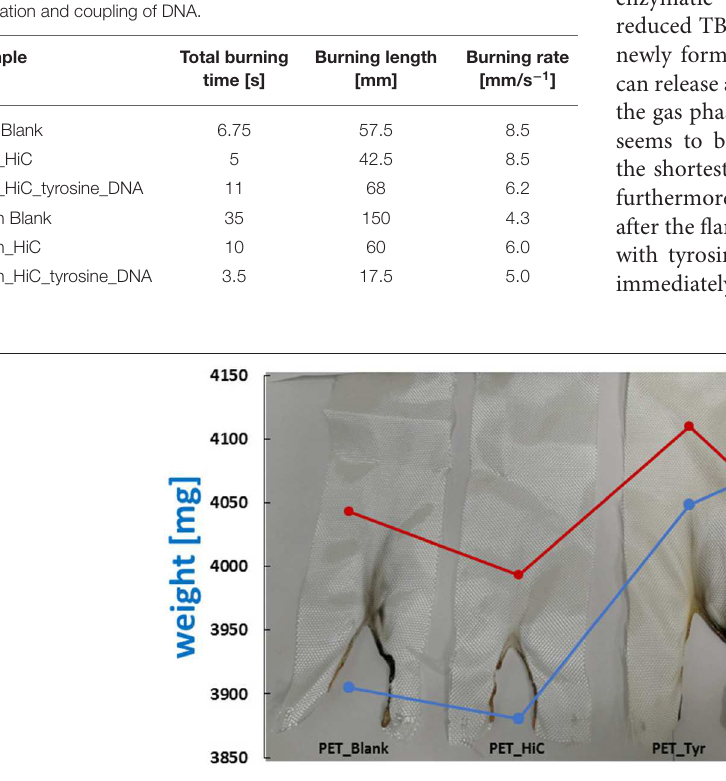
FIGURE 7 | Results of flammability tests of enzymatically activated and tyrosine and tyrosine/DNA treated PET.